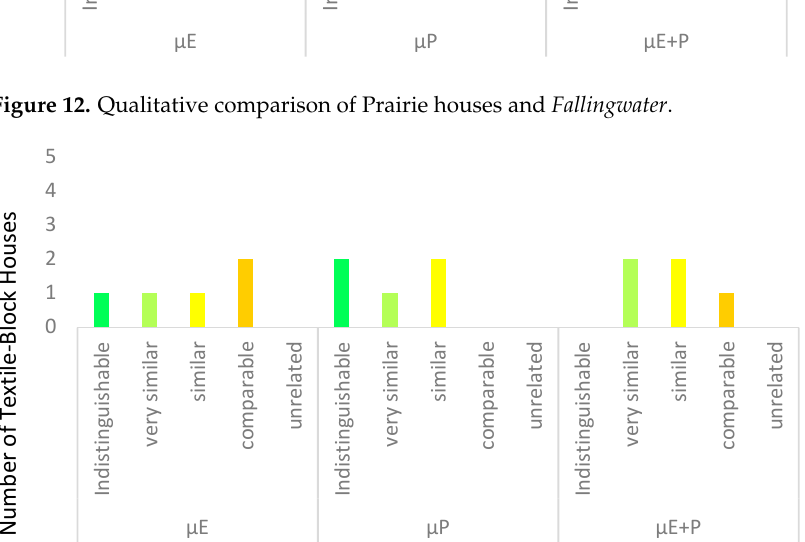
Figure 13. Qualitative comparison of Textile ‐ Block houses and Fallingwater.